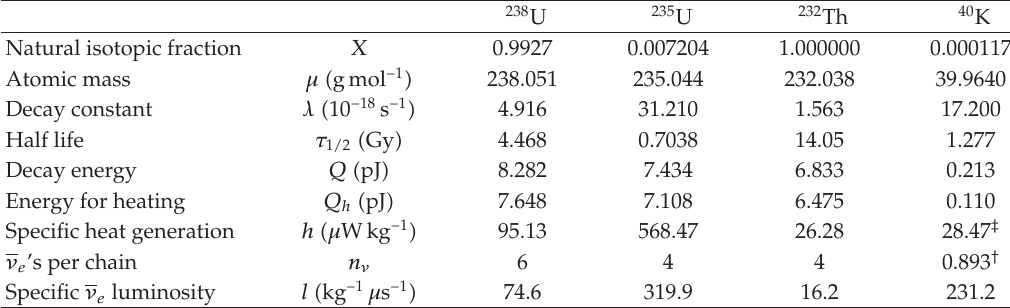
Table 3: Atomic parameters (cid:5) X , μ , λ , τ 1 / 2 , and n ν (cid:6) , total and heating energies per decay (cid:5) Q , Q h (cid:6) , specific heating rates (cid:5) h (cid:6) , and antineutrino luminosities (cid:5) l (cid:6) per unit mass of radionuclide. Adapted from Dye (cid:3) 39 (cid:4) . 238 U 235 U 232 Th 40 K Natural isotopic fraction X 0.9927